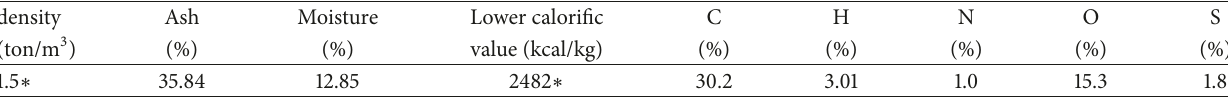
Table 1: The specifications of coal sample ∗